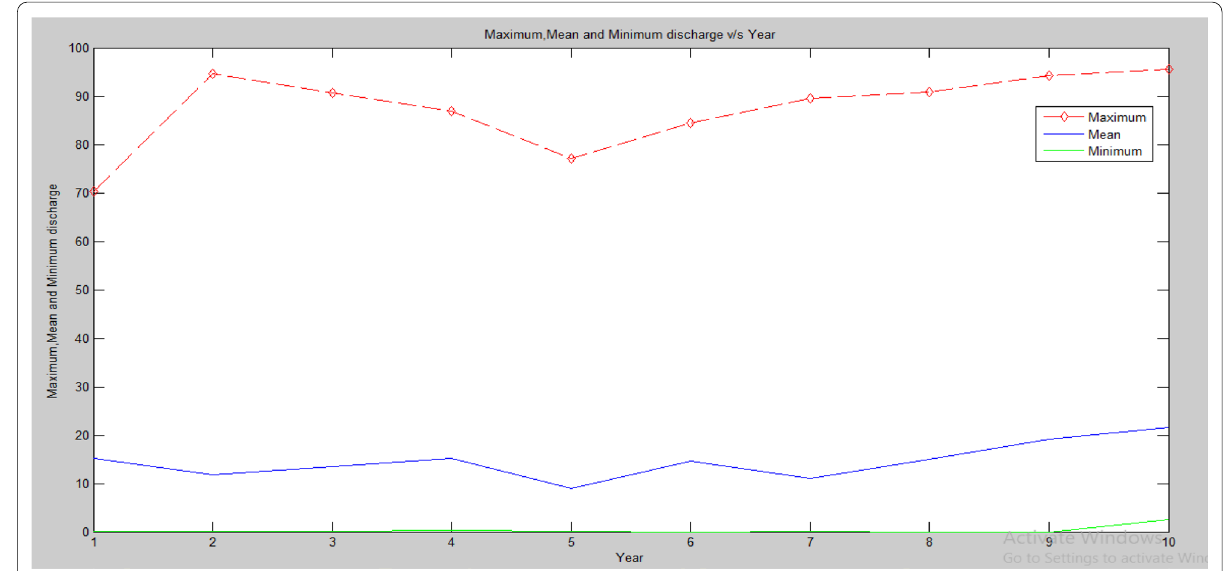
Fig. 3 Curve of maximum, mean and minimum flow discharge v/s year (Fraenkel et al. 1991)